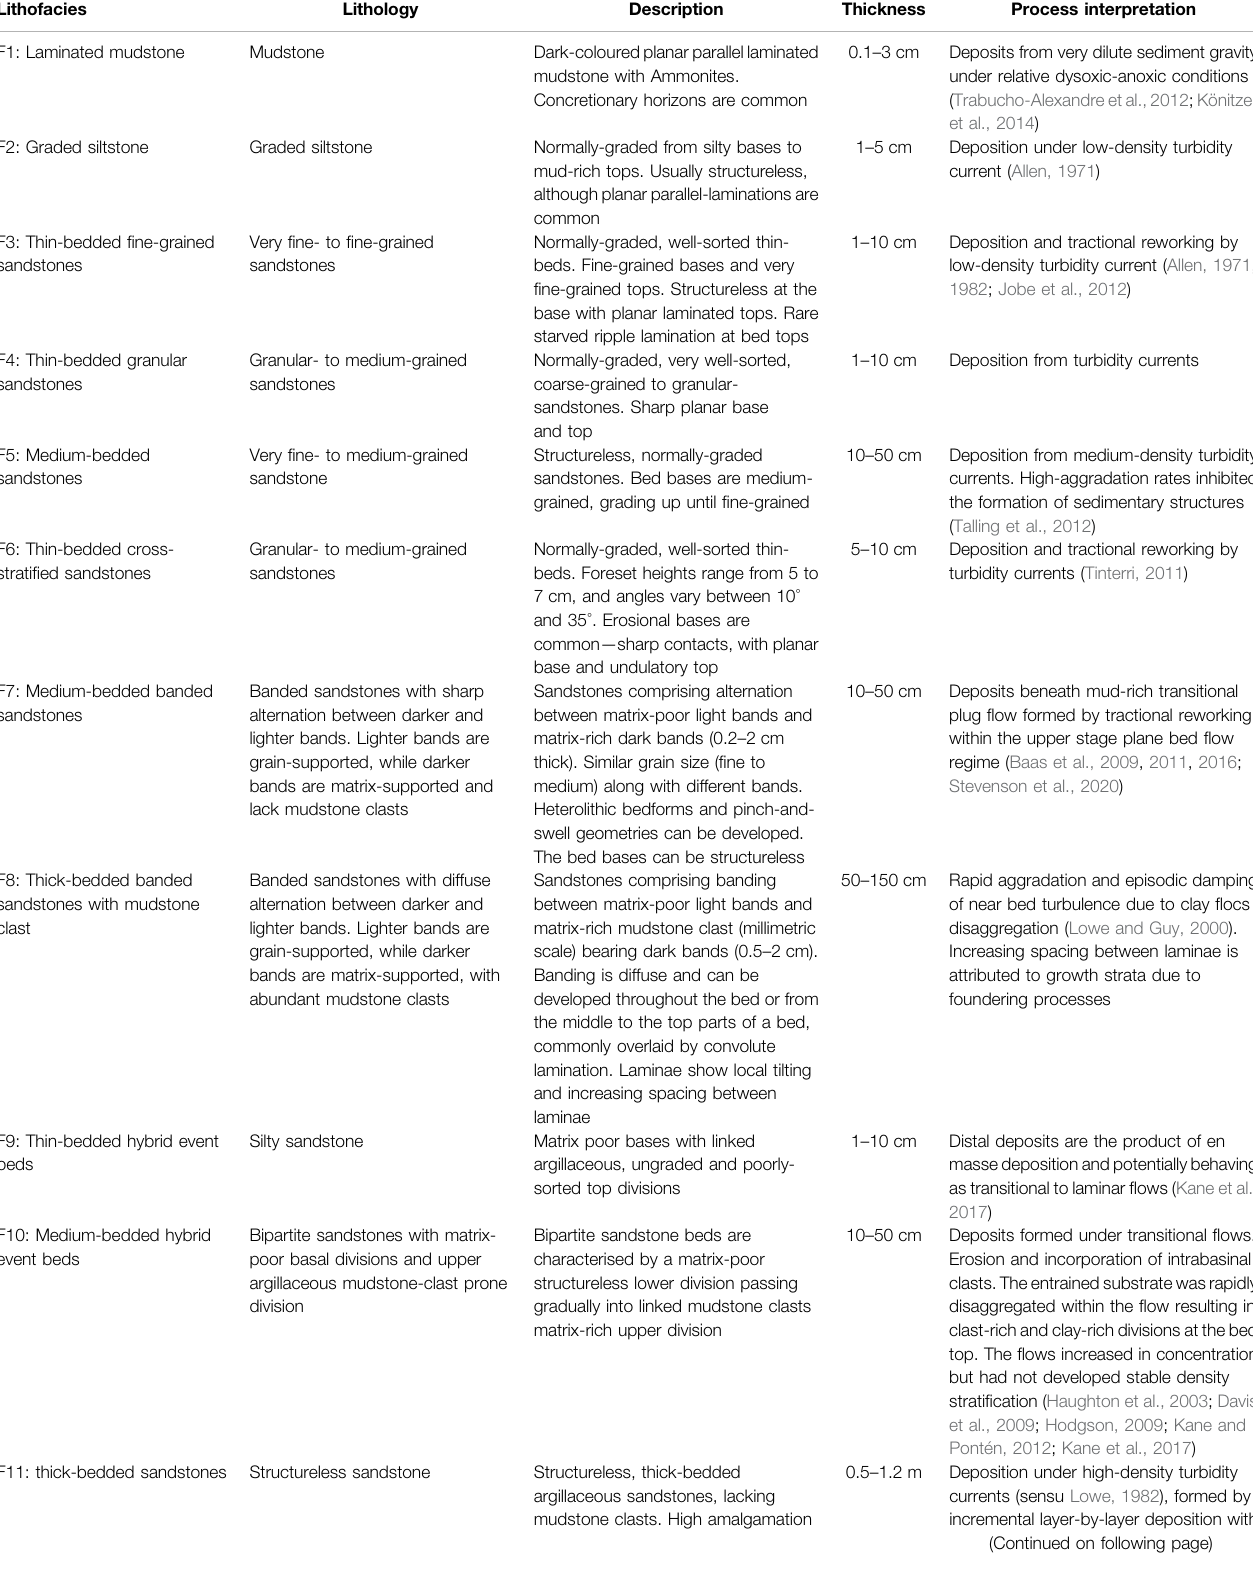
TABLE 1 | Descriptions of the facies recognised in the Los Molles stratigraphy of the Chacay Melehue area, including lithologies, thicknesses, and interpretations of their depositional